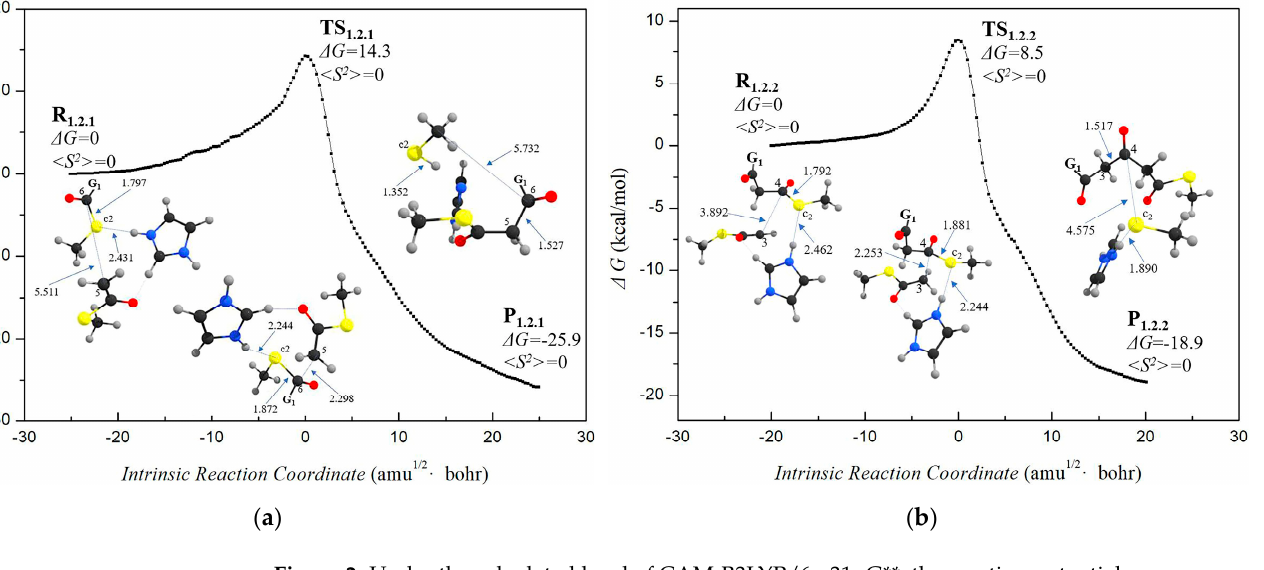
Figure 2. Under the calculated level of CAM-B3LYP/6 − 31+G**, the reaction potential energy curve and the key geometric parameters of each stable point of ( a ) the first condensation processes of thiocaffeoyl methyl ester (1.2.1) and ( b ) the second condensation processes of thiocaffeoyl methyl ester (1.2.2). The reaction mechanism can be seen in Schemes 3–6. Group G 1 is shown in Scheme 1.